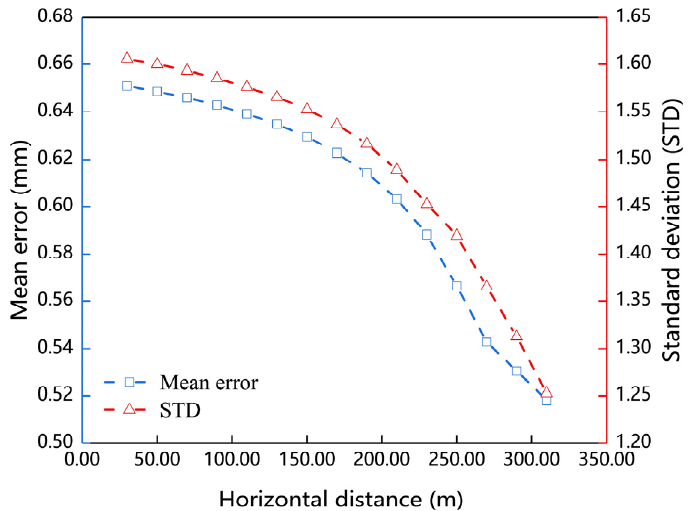
Figure 15. Mean error and standard deviation.